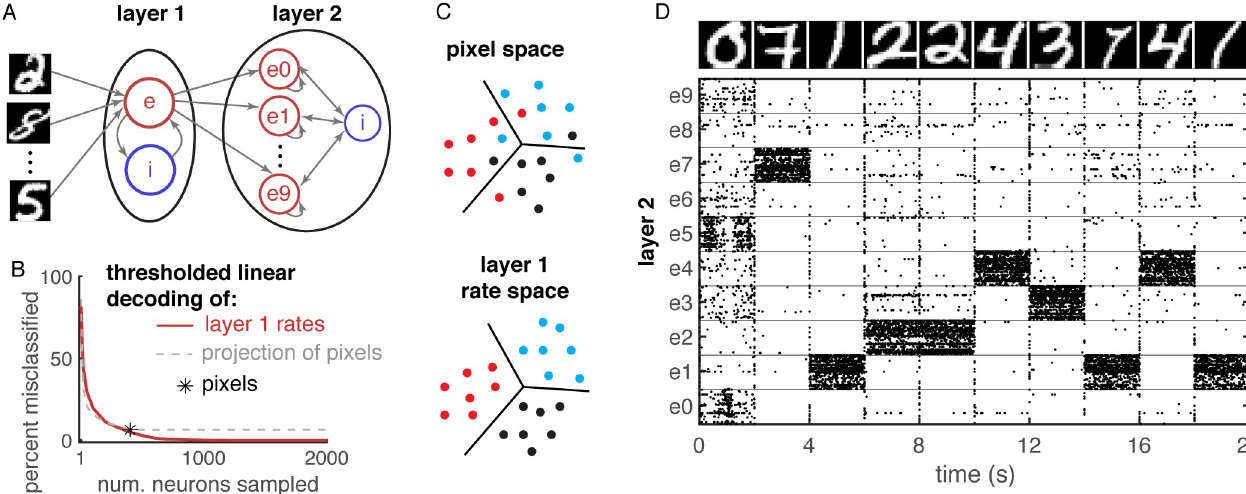
Fig 4. Nonlinear representations in a semi-balanced network improve classification of MNIST digits. A ) Network diagram. Pixel values provided external input to a semi-balanced network identical to the one in Fig 3, representing layer 1. Layer 2 is a competitive, semi-balance network receiving external input from excitatory neurons in layer 1 with inter-laminar weights trained using a supervised Hebbian-like rule to classify the digits. B ) Error rate (percent of 2000 images misclassified) of a thresholded linear readout of excitatory firing rates from layer 1 with readout weights optimized to classify the images, plotted as a function of the number, n , of neurons sampled (red). Black asterisk shows the error rate of an optimized readout of the n = 400 image pixels. Dashed gray shows the error rate of a thresholded linear readout of a random projection of the pixels into n dimensions. The error rate of the rate readout (red curve) is zero for n � 1600. C ) Diagram illustrating linear separability in rate space, but not pixel space. Different colors represent different digits. D ) Raster plot of 500 randomly selected neurons from layer 2 (50 from each population, ek ) when images at top were provided as external input to layer 1.